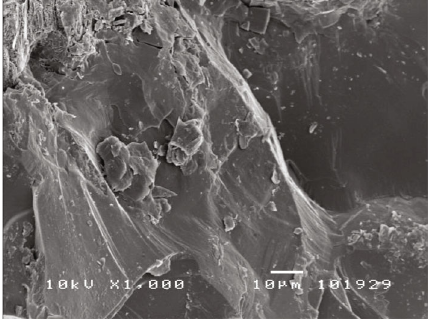
Figure 19: Arc groove pattern (-30 ° C, ×